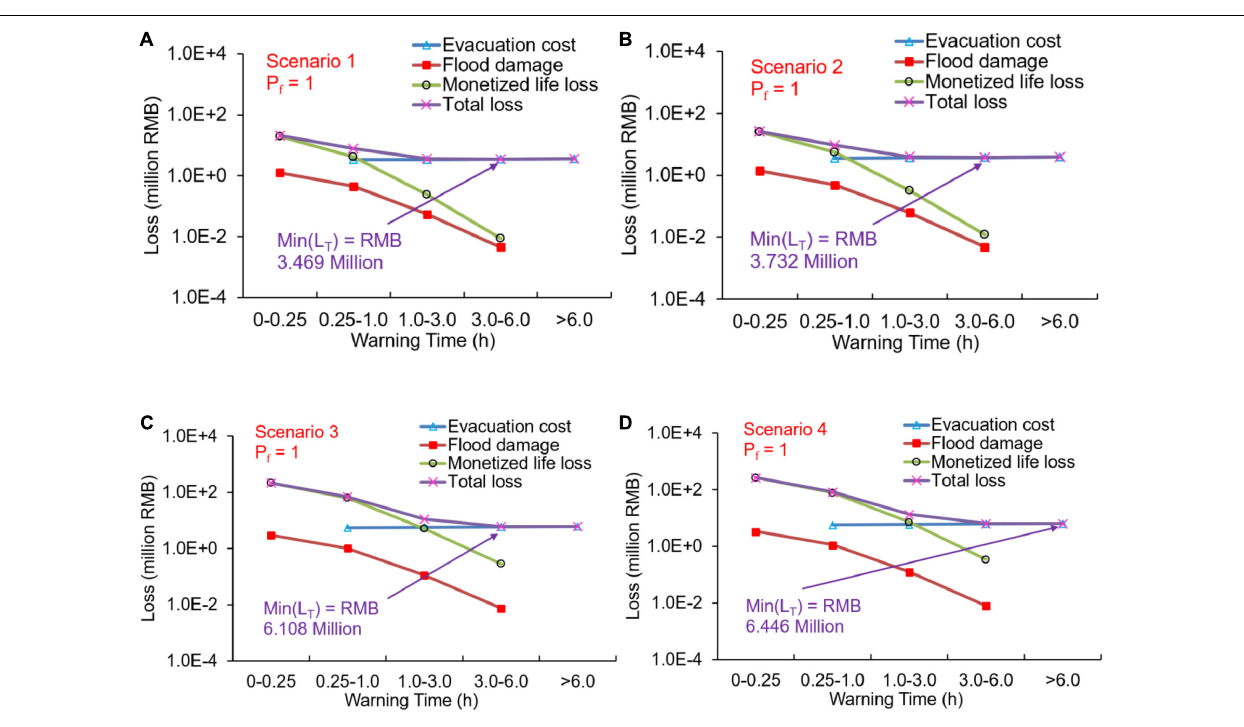
of 0–4.8 km), “Building story number” was assumed as 3